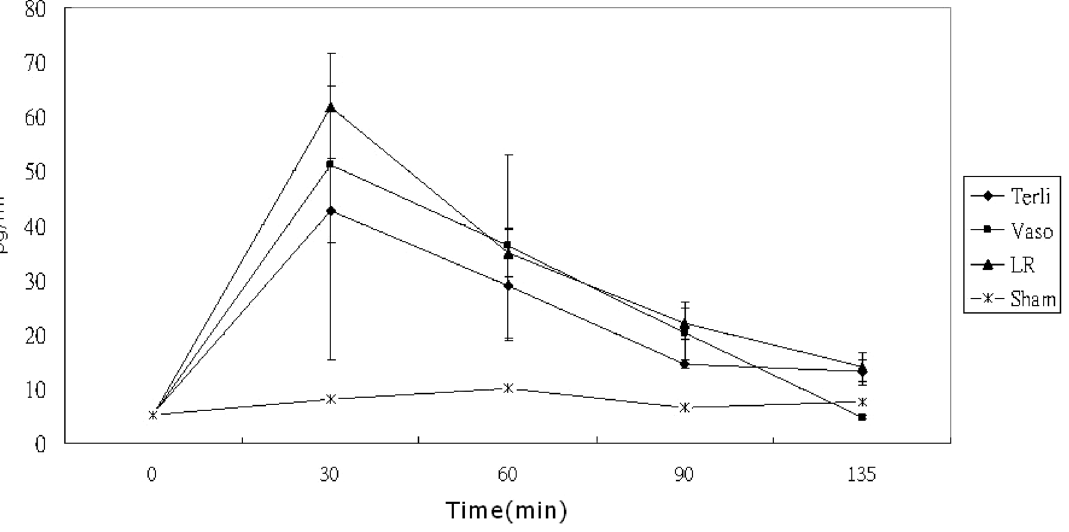
Figure 4. Comparison of serum TNF-alpha levels between different resuscitation strategies groups from 0 to 135 min. Data are shown as mean values and standard deviations. There were no significant differences in baseline levels and the serum TNF-alpha levels over time.